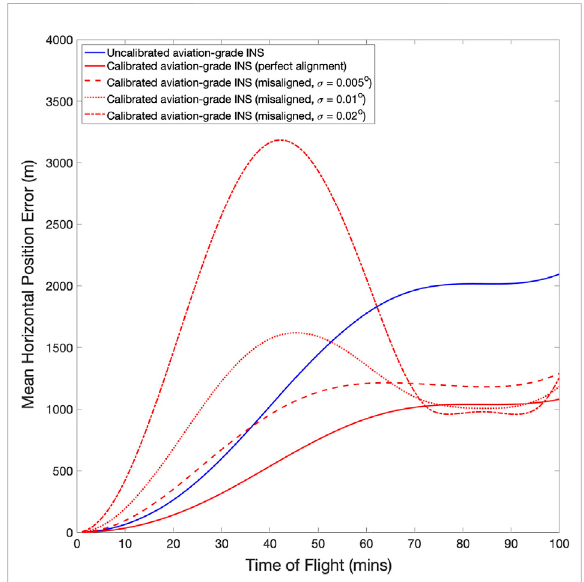
FIGURE 3 Mean horizontal error for an uncalibrated aviation-grade INS solution (blue), an online calibrated aviation-grade INS that is perfectly aligned to perfect cold atom sensors (red, solid), and an online calibrated aviation-grade INS that is misaligned with respect to the cold atom sensors: standard deviation of the misalignments in each axis σ =0.005 o (red, dash), σ =0.02 o (red, dotted), and σ =0.02 o (red, dot-dash). The means are calculated over 50 realisations of the errors for the full